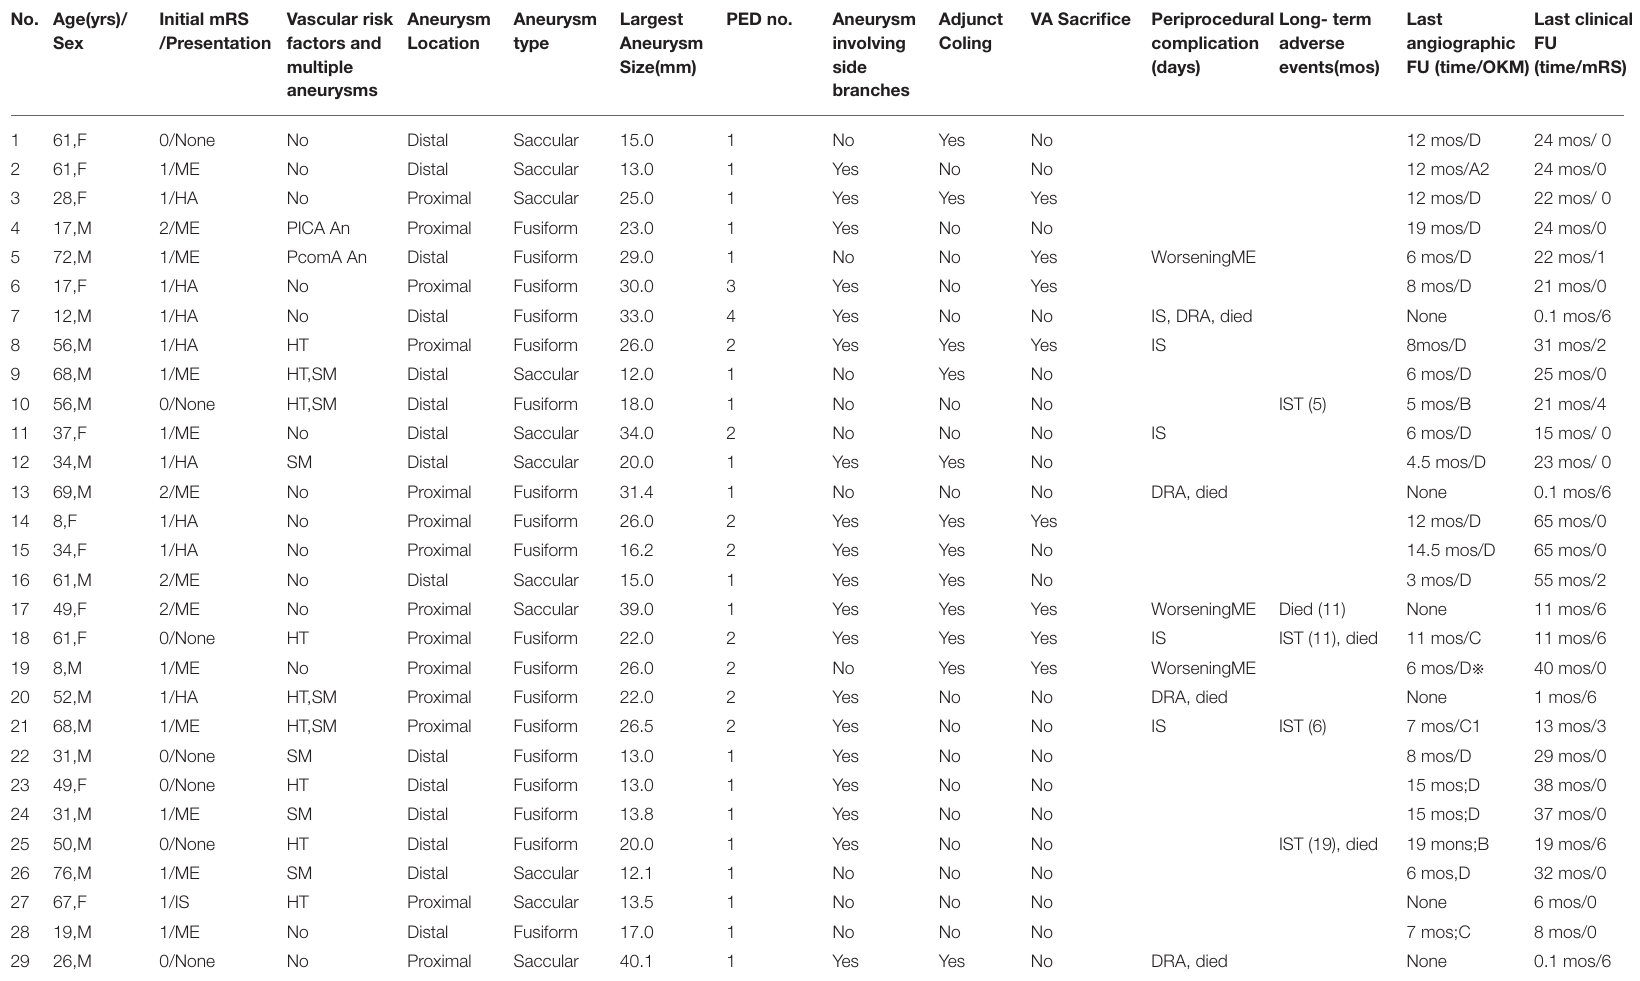
TABLE 1 | Patient and aneurysm characteristics, procedural details, complications, and